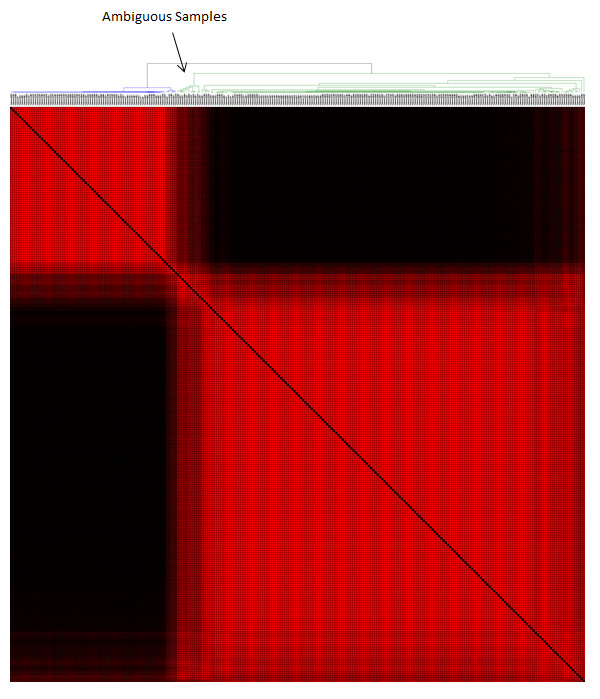
Identifying ambiguous samples using mRNA levels. K-means clustering yielded two distinct subclusters which may represent subtypes that will be addressed in the future. The 20 samples which did not cluster well with either group were classified as ambiguous samples and removed.